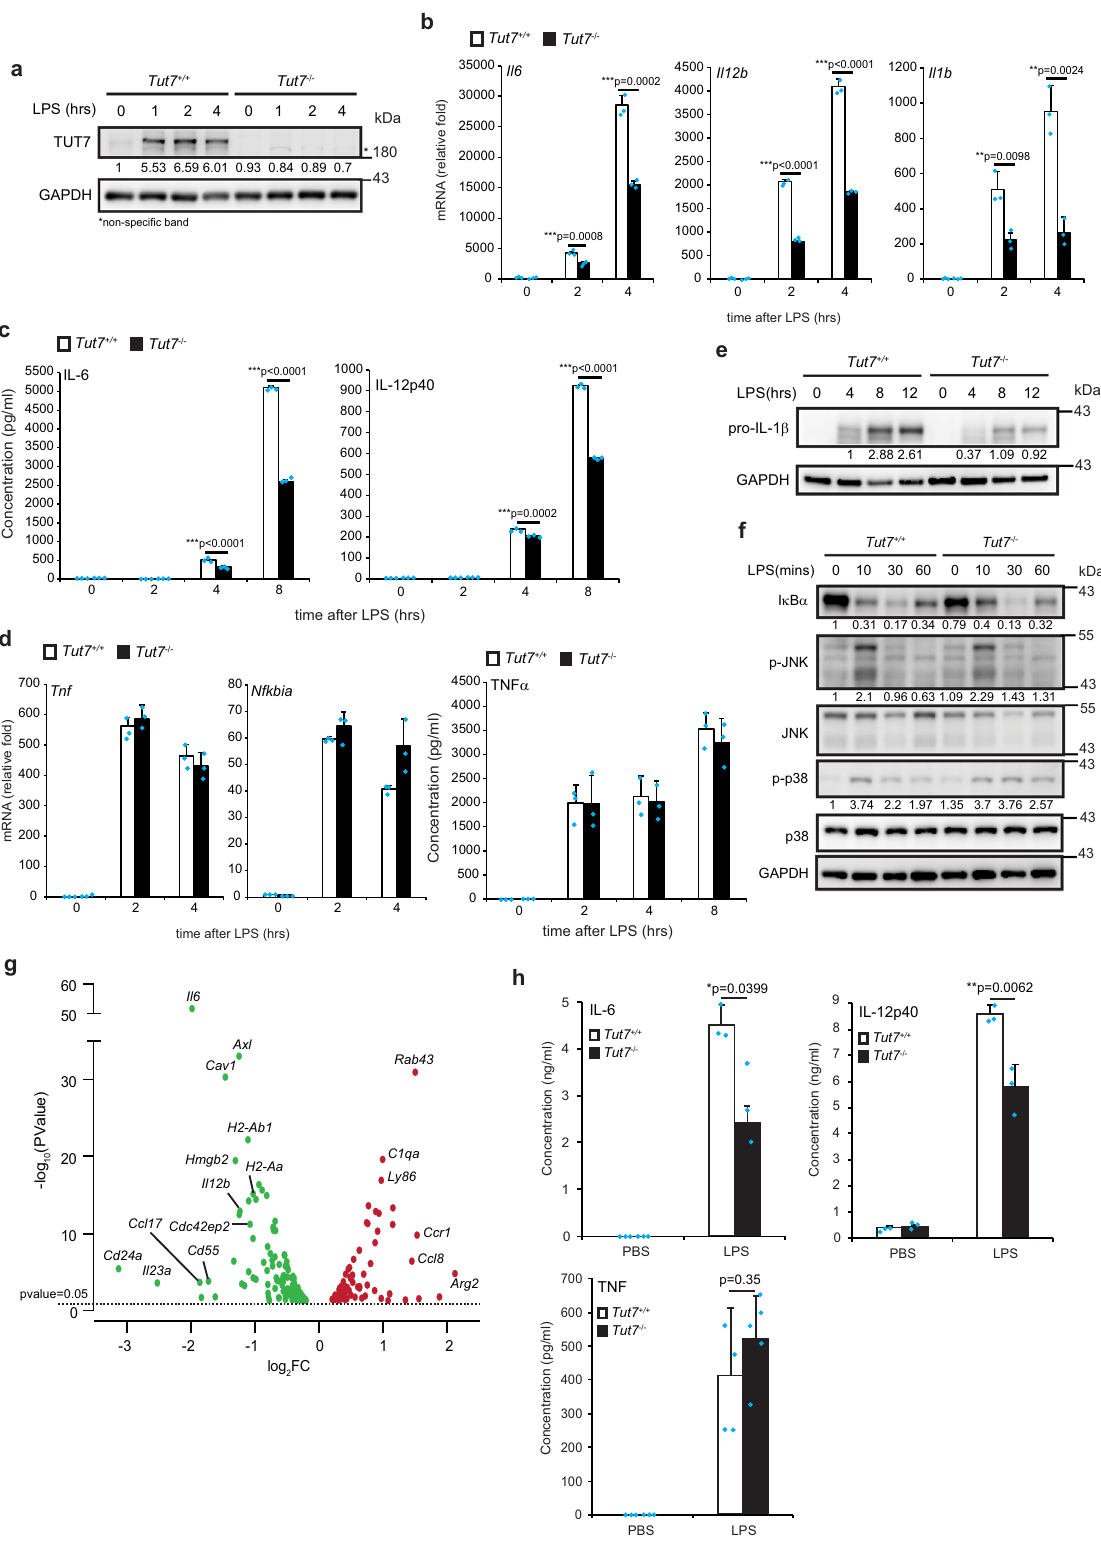
upon LPS challenge (Supplementary Fig. 1d – h). Nevertheless, LPS-induced I κ B α degradation, activation of MAPKs JNK and p38, and nuclear translocation of IRF3 were comparable in control and TUT7-silenced cells (Supplementary Fig. 1i, j).